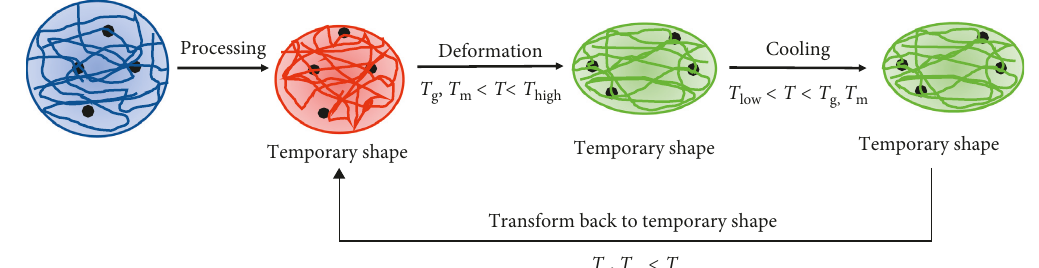
Figure 4: Thermomechanical cycle of thermally responsive shape memory polymers.